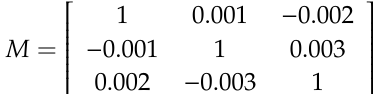
Figure 5. Deviation angle error(arc-second) estimation with frame in 0.06, 0.1